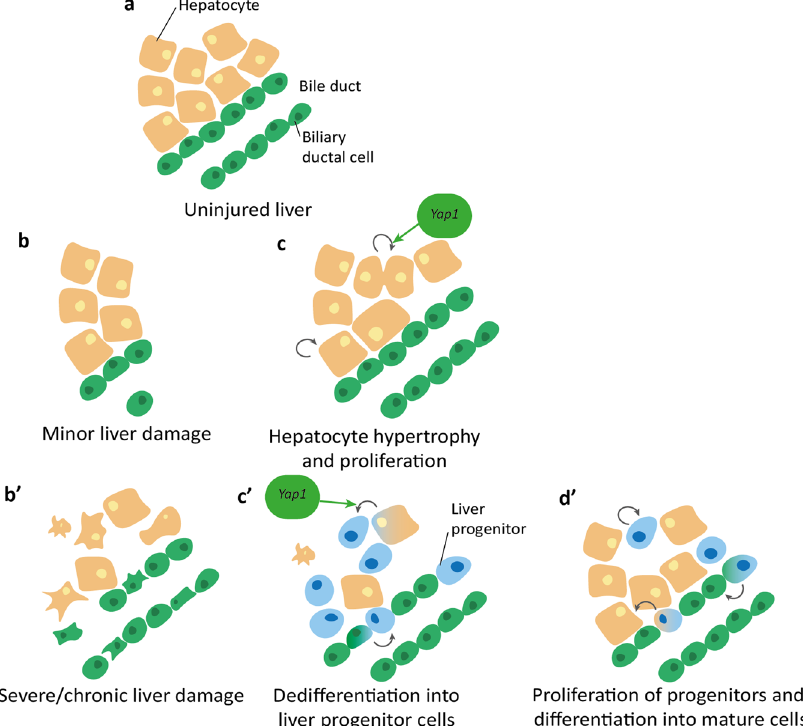
Fig. 7 Overview of liver regeneration after minor (b, c) and severe (b ’ , c ’ , d ’ ) injury. a Healthy (uninjured) zebra fi sh liver consists of multiple cell types hepatocytes (orange) and bile ducts comprising of biliary ductal cells (green). b Minor liver injury such as partial hepatectomy removes portions of the liver and the associated cells. c Liver recovery after minor liver damage involves hypertrophy and increased proliferation of remaining cells. Yap1 promotes hepatocyte proliferation. b ’ Chronic or severe liver damage causes widespread cell death